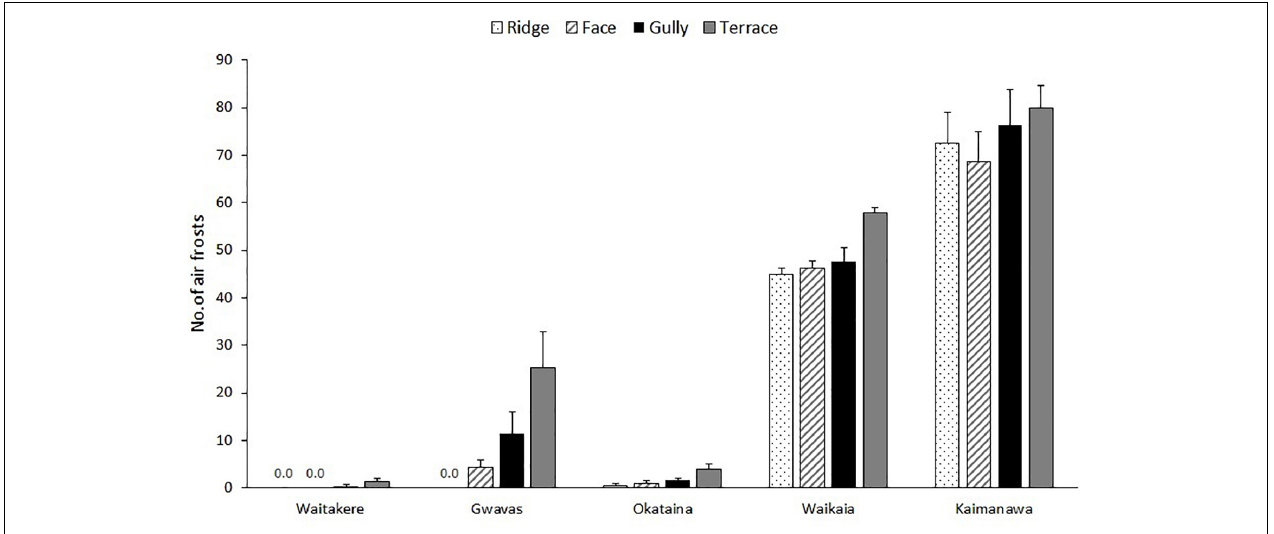
FIGURE 2 | Effect of topography on frequencies of air frosts at 1m aboveground beneath single-tree canopy gaps, at five localities differing widely in macroclimate, over a 340-day period between spring 2017 and spring 2018. Graph shows means ( ± 1 se) of measurements at three to six replicate ridges, terraces and gullies and up to six replicate